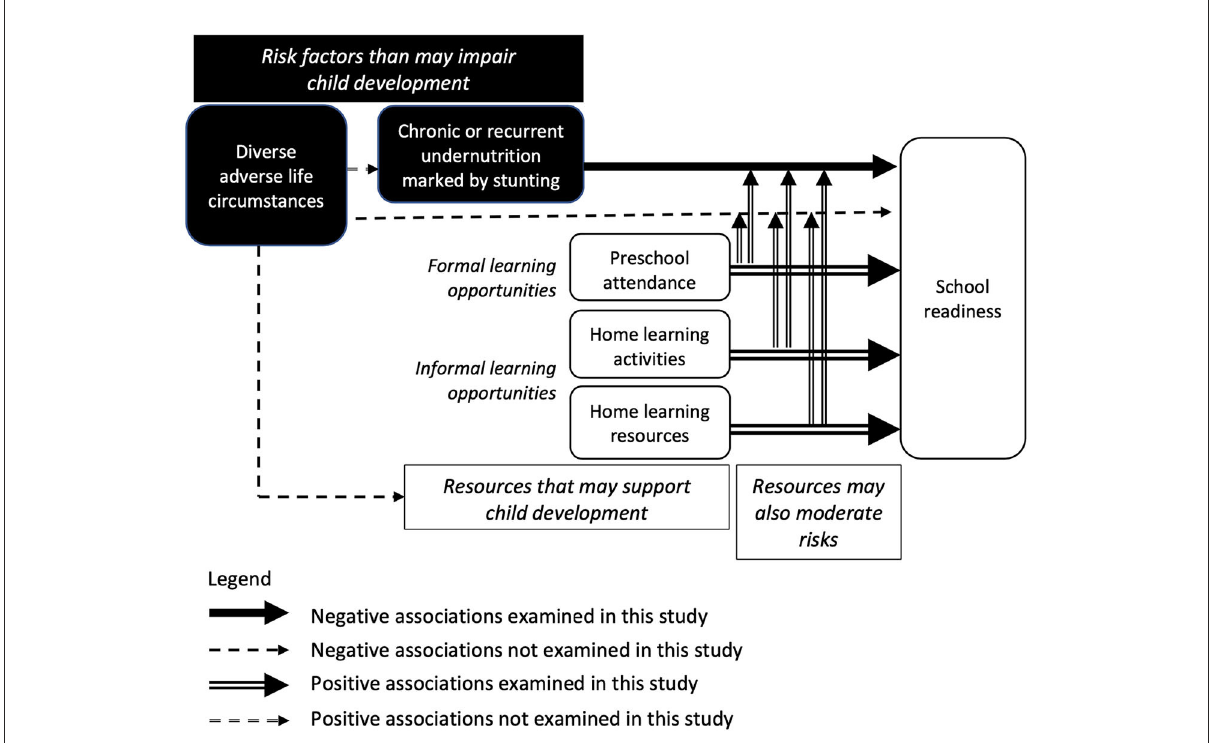
FIGURE1 Conceptual model underlying the current